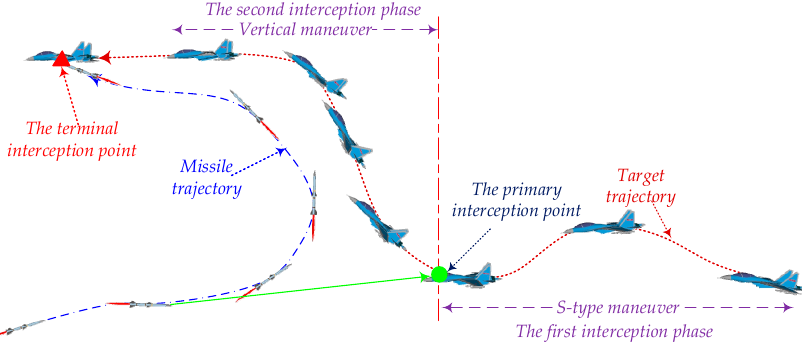
Figure 1. The target with different maneuver modes during the interception.